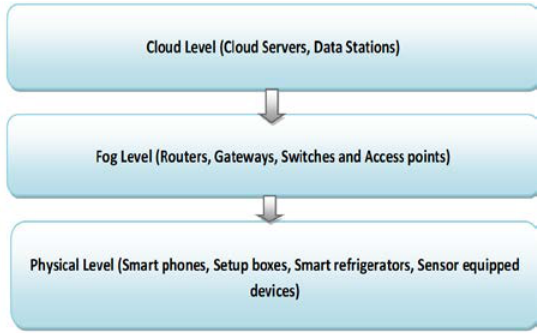
Figure 1. General three level architecture of fog computing.